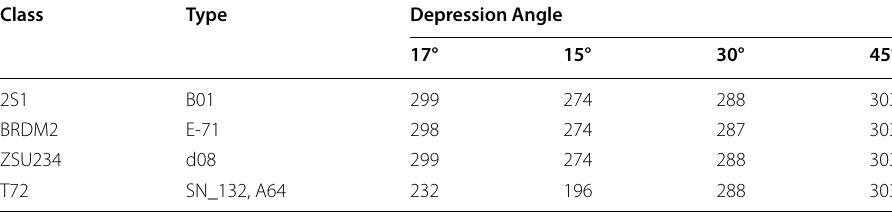
Table 2 Numbers of SAR images of different targets under different depression angles Class